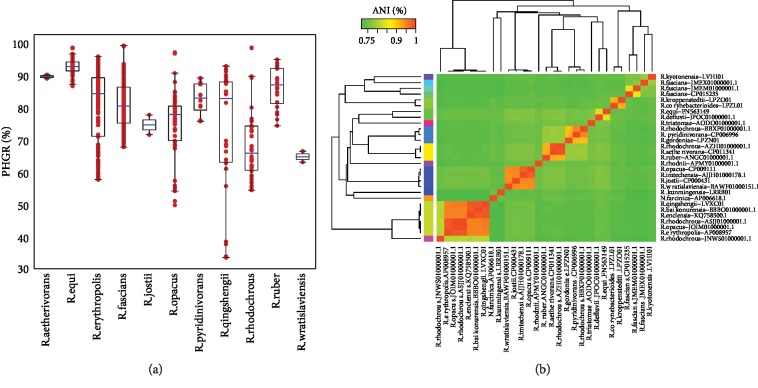
The genomic conservation of Rhodococcus species. (a) PHGR of Rhodococcus species. It was determined by summation of all homologous genes found in any pair of genomes divided by the total gene number of each genome and was shown as boxplots. Boxplots indicate 0.25 and 0.75 quantiles, and the blue lines represent the median values of PHGR of each species. (b) Clustering analysis of 28 representative Rhodococcus genomes and a closely related genome (Nocardia farcinica) based on the ANI matrix.